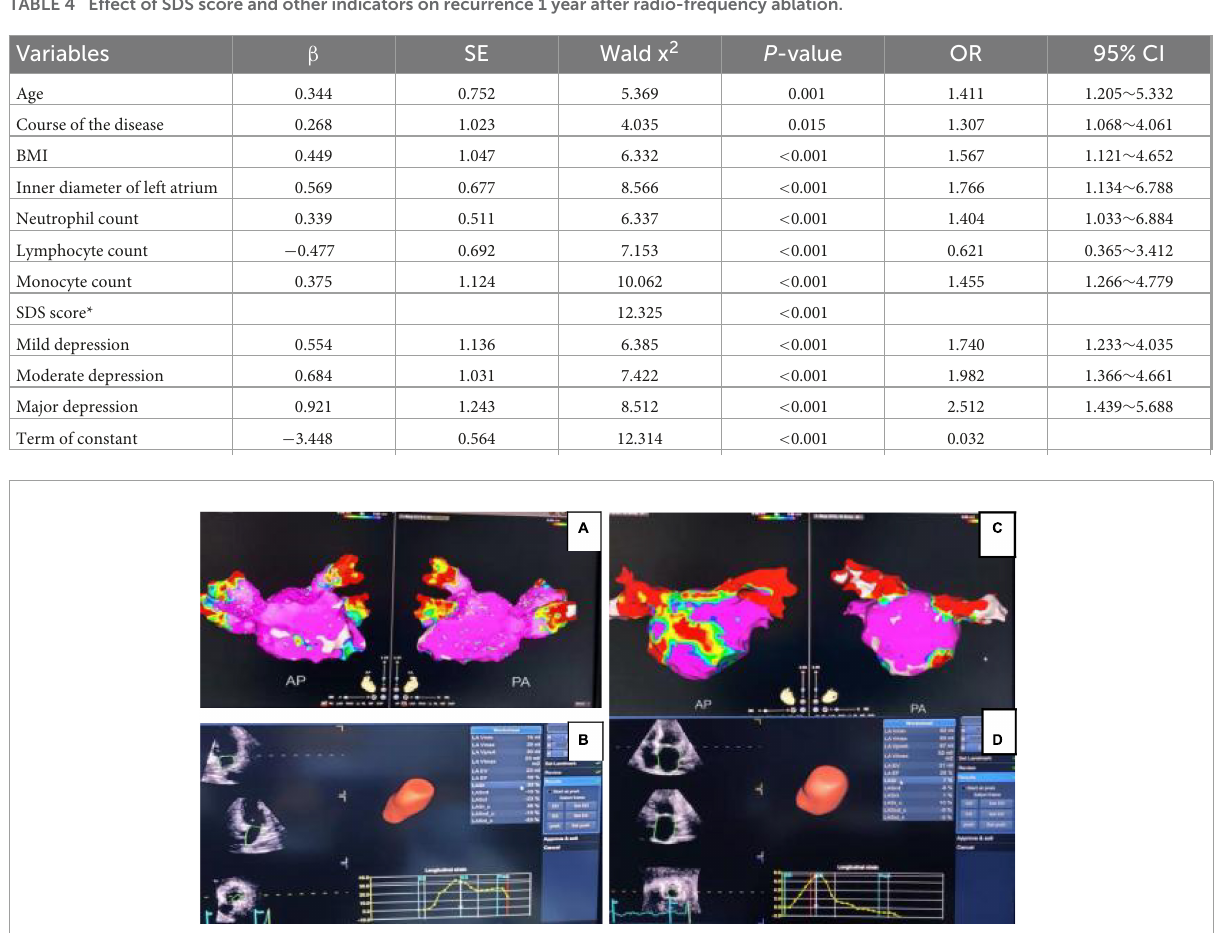
FIGURE1 Forest plot of 1-year risk of relapse for the patients with AF after radio-frequency ablation. In panel (A) , the left atrial diameter is normal. Group electro-anatomical mapping sample diagram, purple represents non-low voltage region; (B) is the echocardiography of the same patient without recurrence. In panel (C) , the left atrial diameter of the relapsed group increased significantly and purple represents the non-low voltage region. (D) is the echocardiogram of the same patient in the relapse